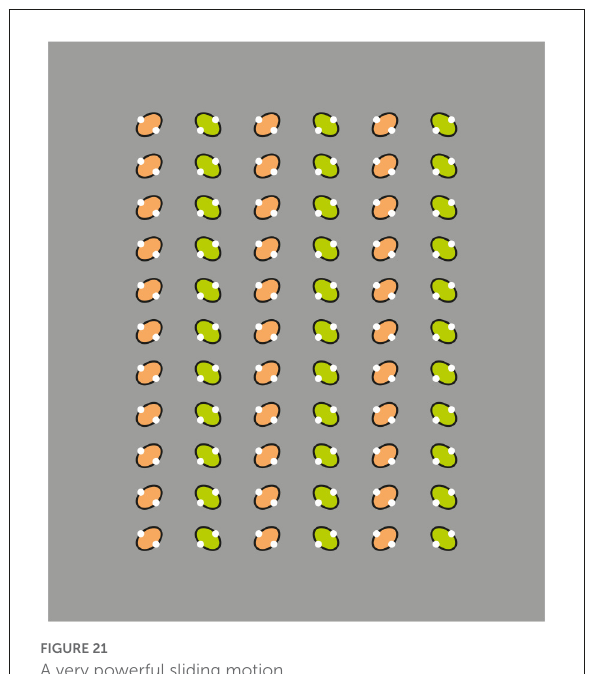
FIGURE21 A very powerful sliding